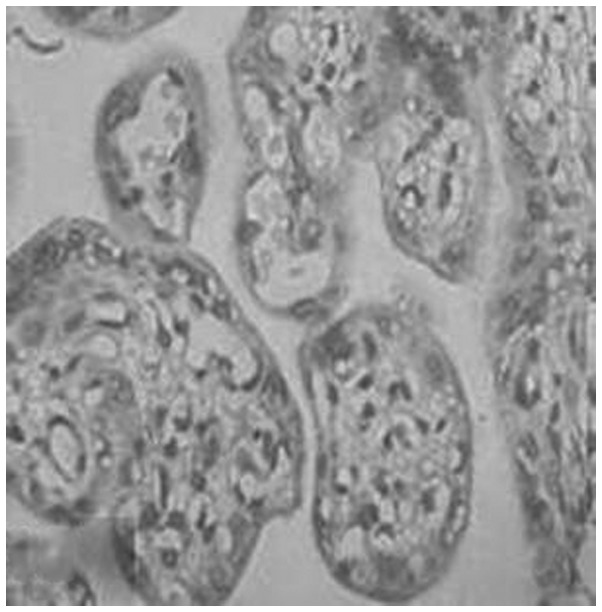
Immunohistochemical staining for tissue inhibitor of metalloproteinase-1 in a normal placenta. Magnification, ×400.